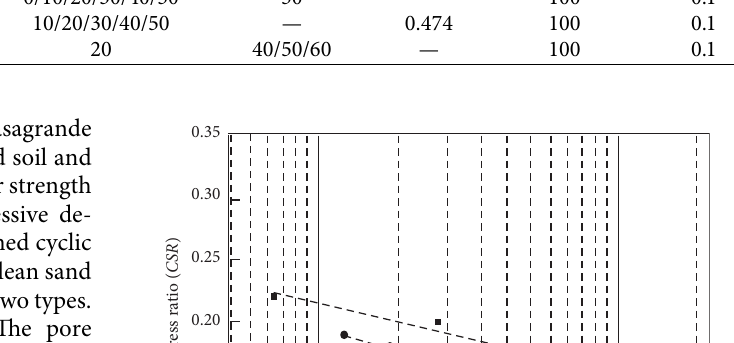
L of FS mixtures at